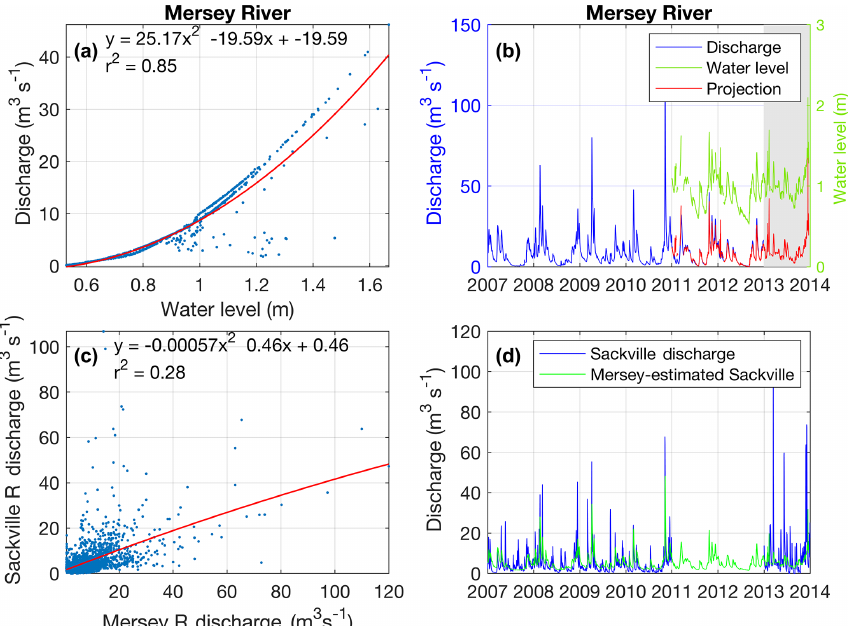
Figure 4. (a) Discharge to water level relation for Mersey River for the reanalysis period. (b) Projection of discharge via water level (using relation in a ) for periods of missing discharge data indicated by the gray background. (c) Comparison between Mersey River and Sackville River discharge over the reanalysis period to find a suitable relation. (d) Observed Sackville discharge (blue) and predicted Sackville discharge (green) based on relation in (c) . Mersey and Sackville River locations are noted in Fig.